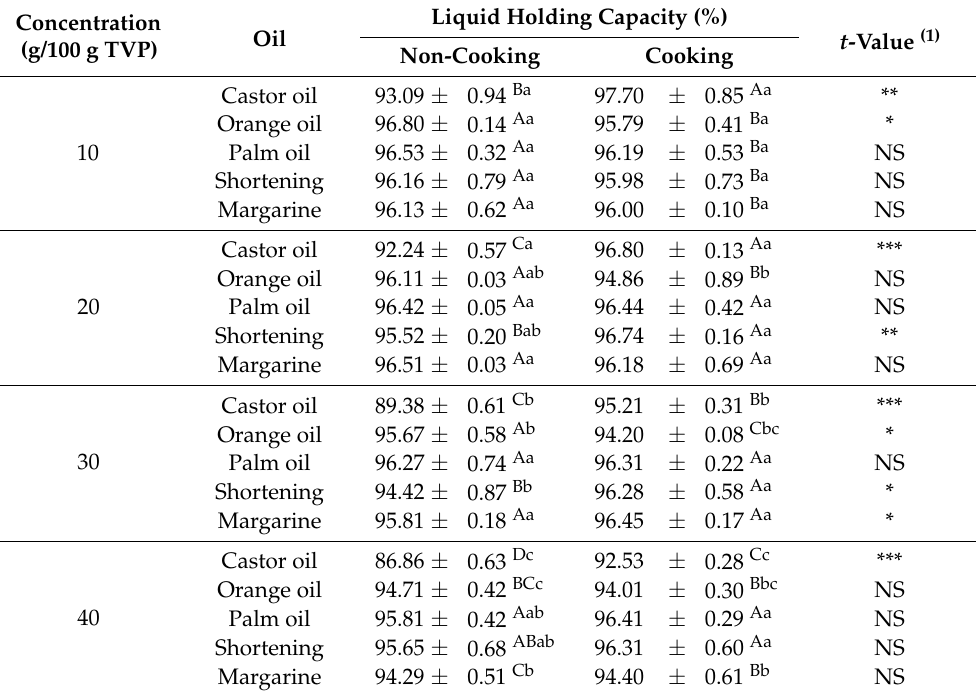
Table 4. Liquid holding capacity (%) of meat analog supplemented with different types or amounts of vegetable oils stored at 4 ◦ C